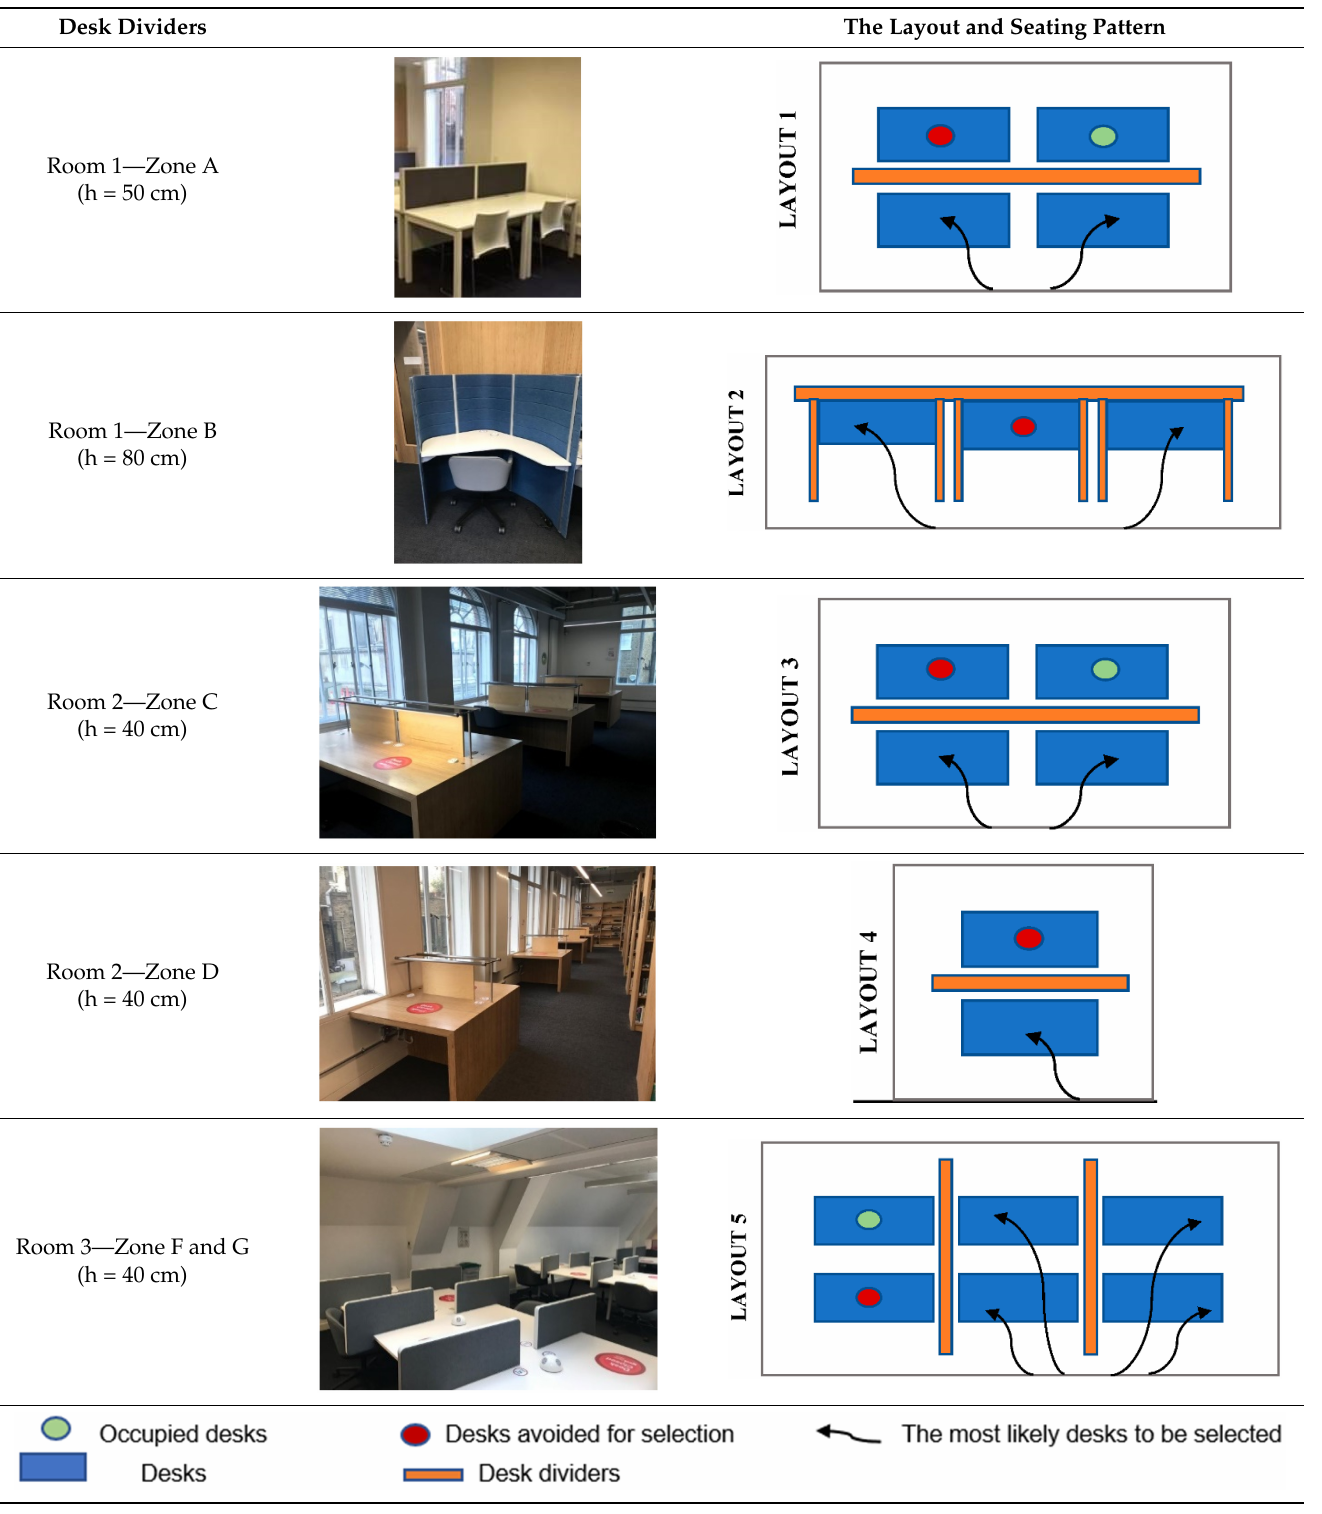
Table 4. Type of desk dividers in the library and the most likely seating